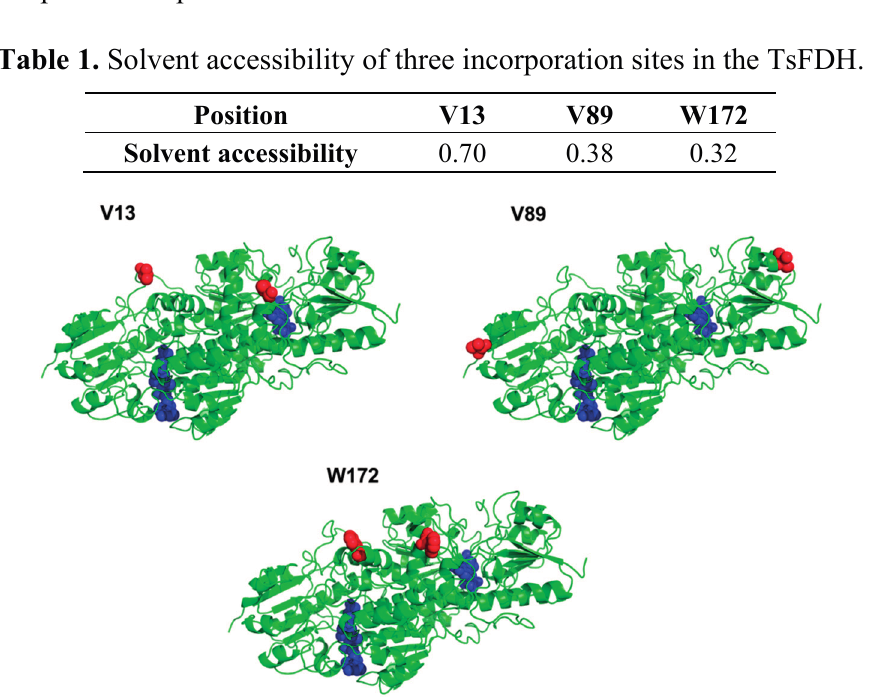
Figure 1. Selection of pAzF incorporation sites in the homodimeric